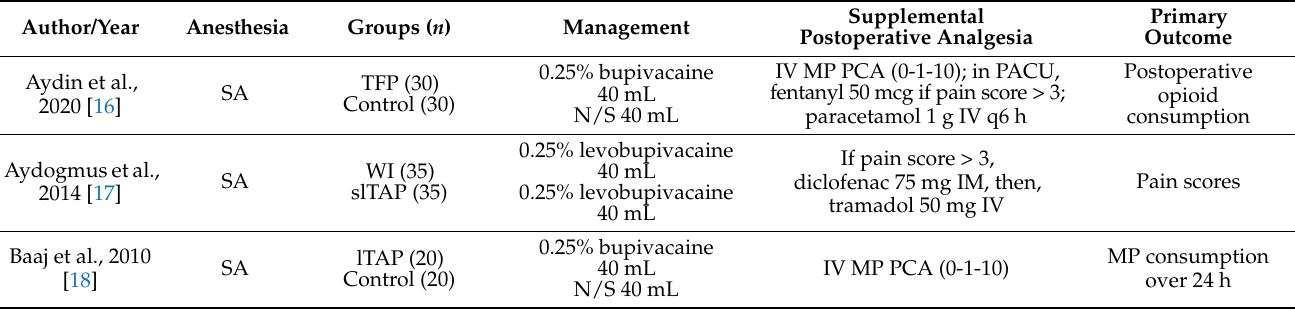
Table 1. Summary of study characteristics in included